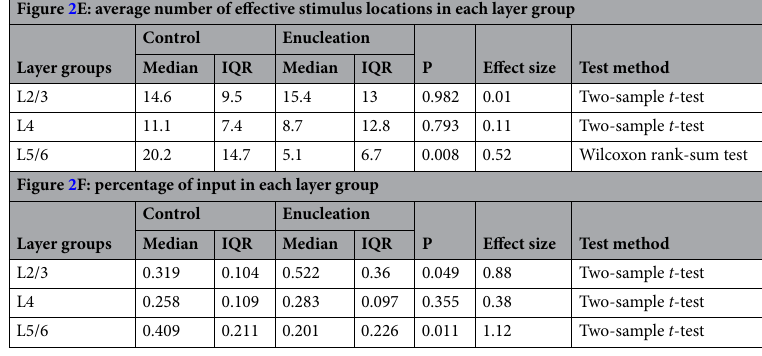
Table 2. Statistics in Fig. 2. IQR interquartile range.